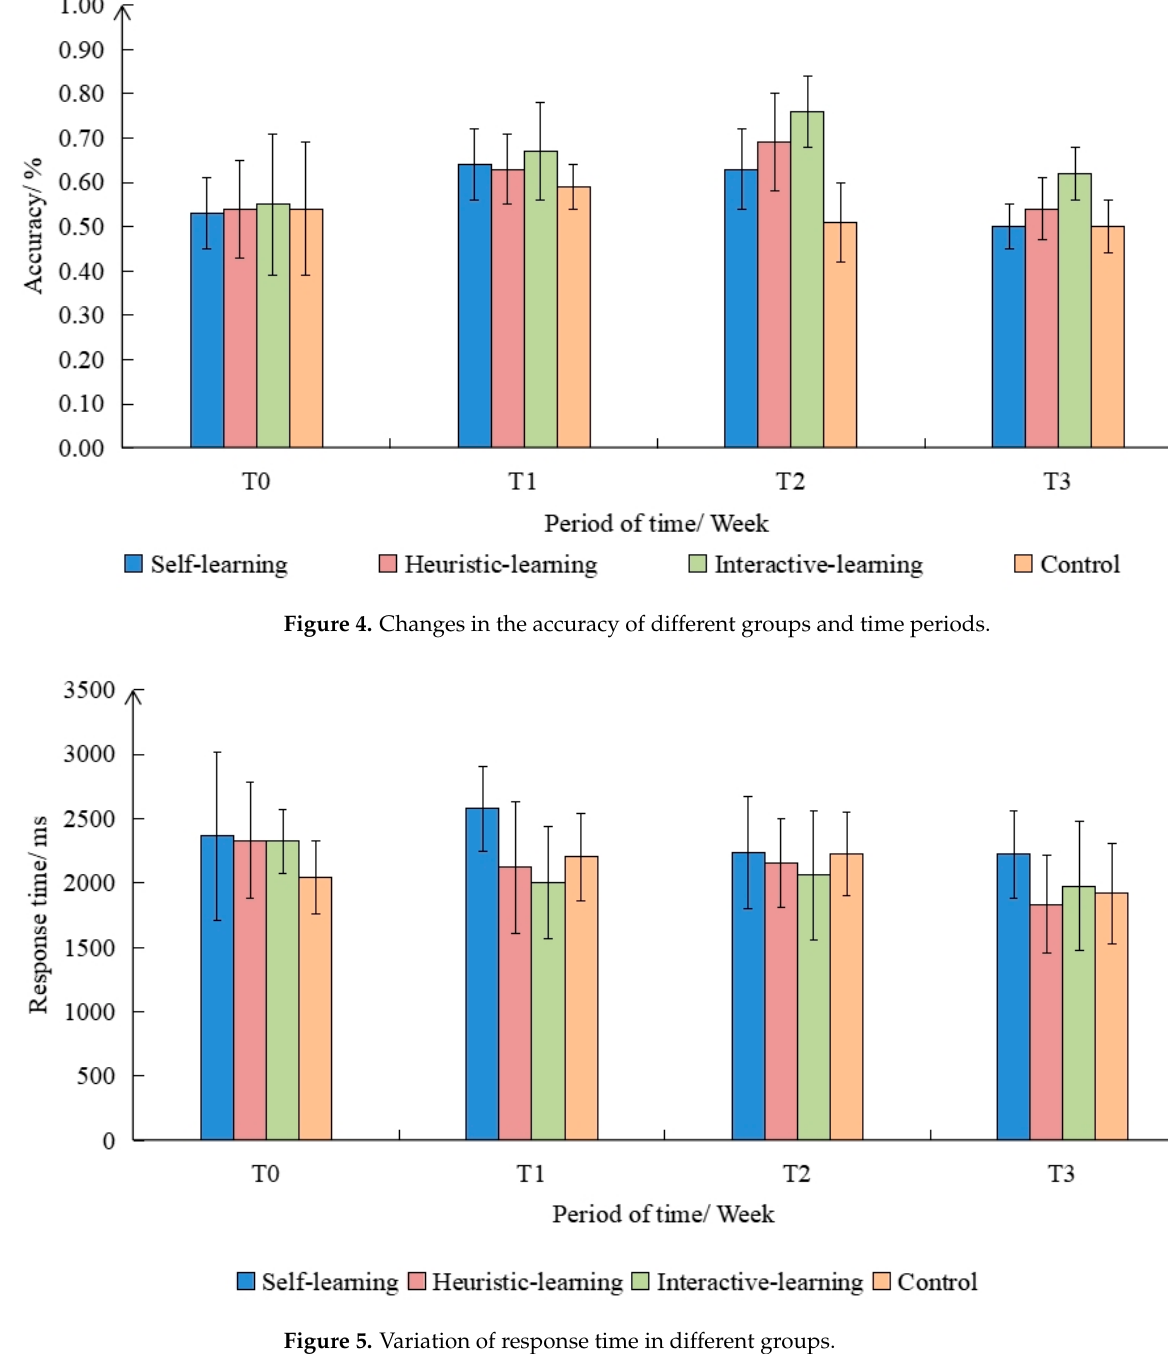
Figure 5. Variation of response time in different groups.